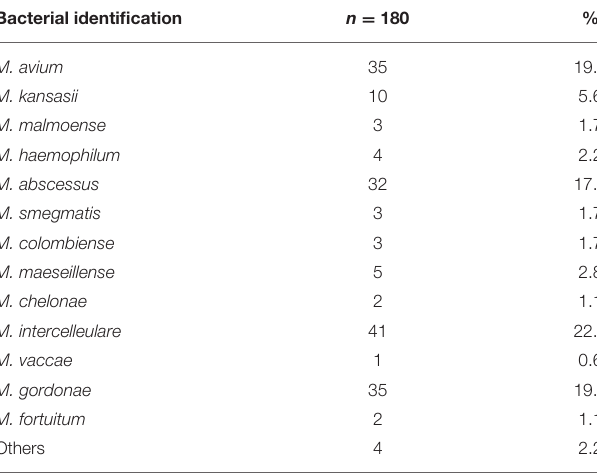
TABLE 3 | Bacterial identification in patients with NTM lung